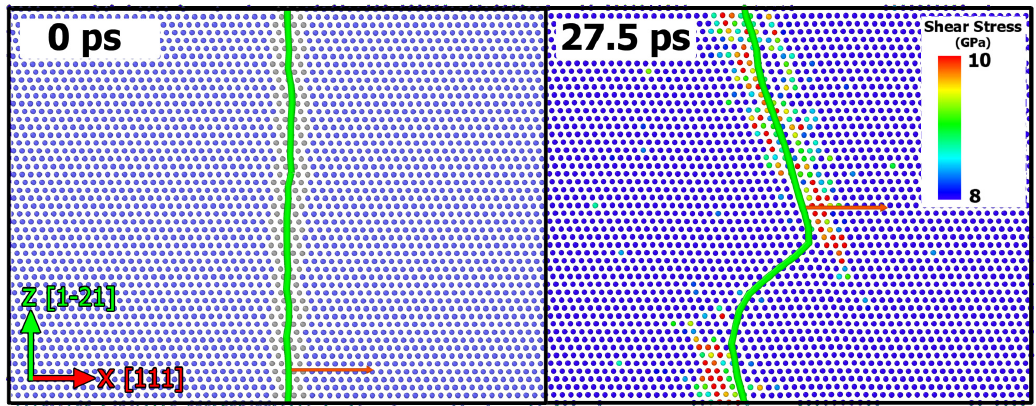
Figure 9. Dislocation shapes of the 1/2 [ 111 ] ( ¯101 ) dislocation at 0 ps and 27.5 ps (2.5% strain). The original dislocation is on the left and the dislocation after compression at a strain of 2.75% (27.5 ps) is on the right. Atoms are colored according to their shear stress in